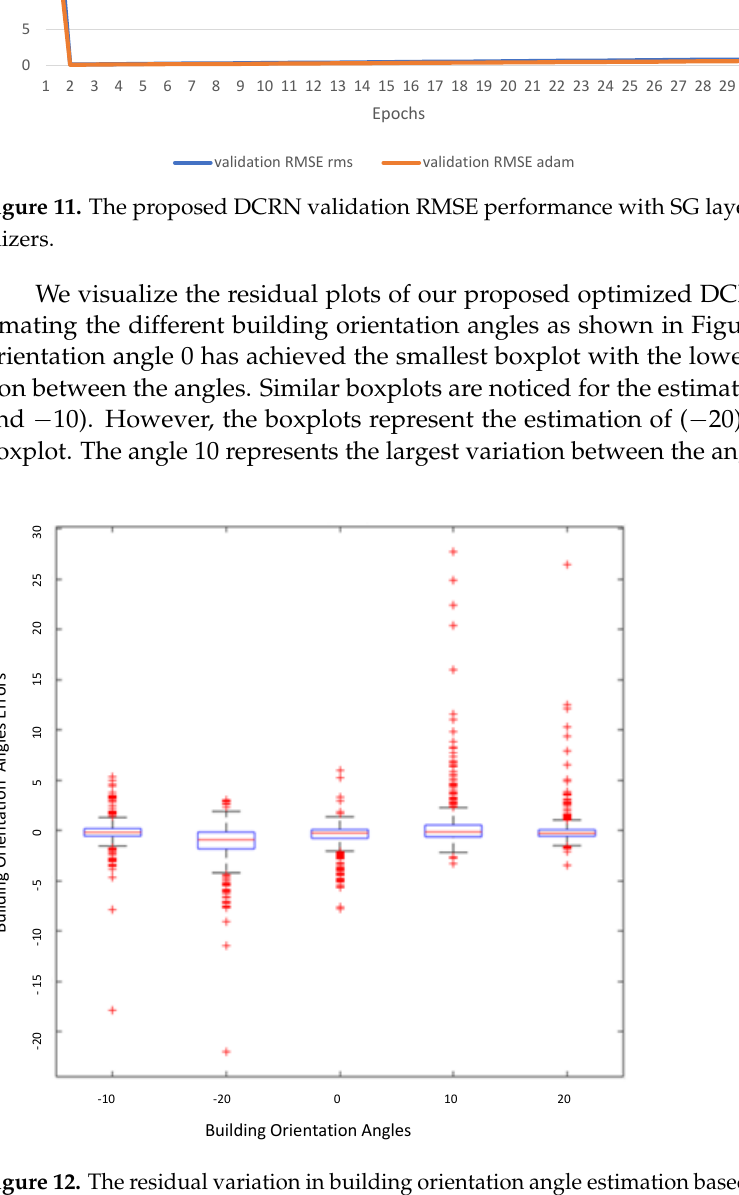
Figure 12. The residual variation in building orientation angle estimation based on Boxplots